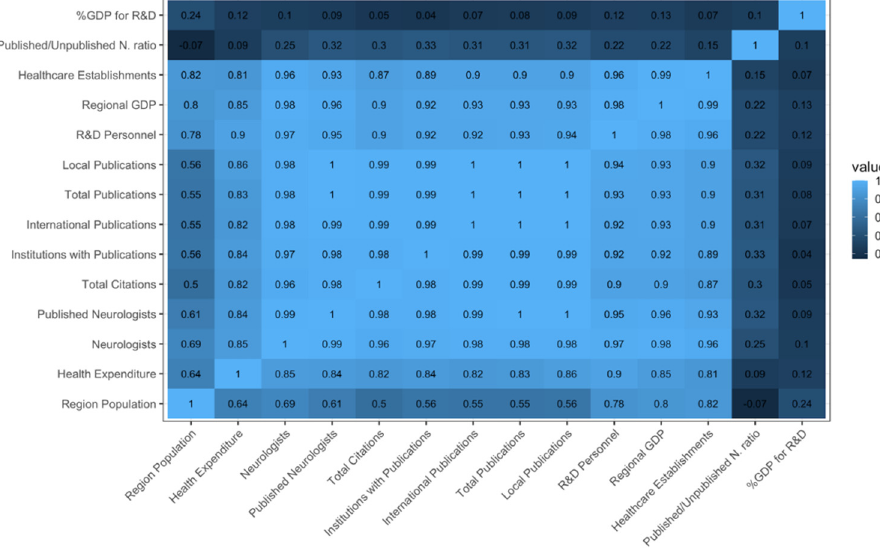
Figure 5. Correlation heatmap of bibliometrics, socioeconomic, healthcare, and research indices. Values closer to 1 have greater correlation.